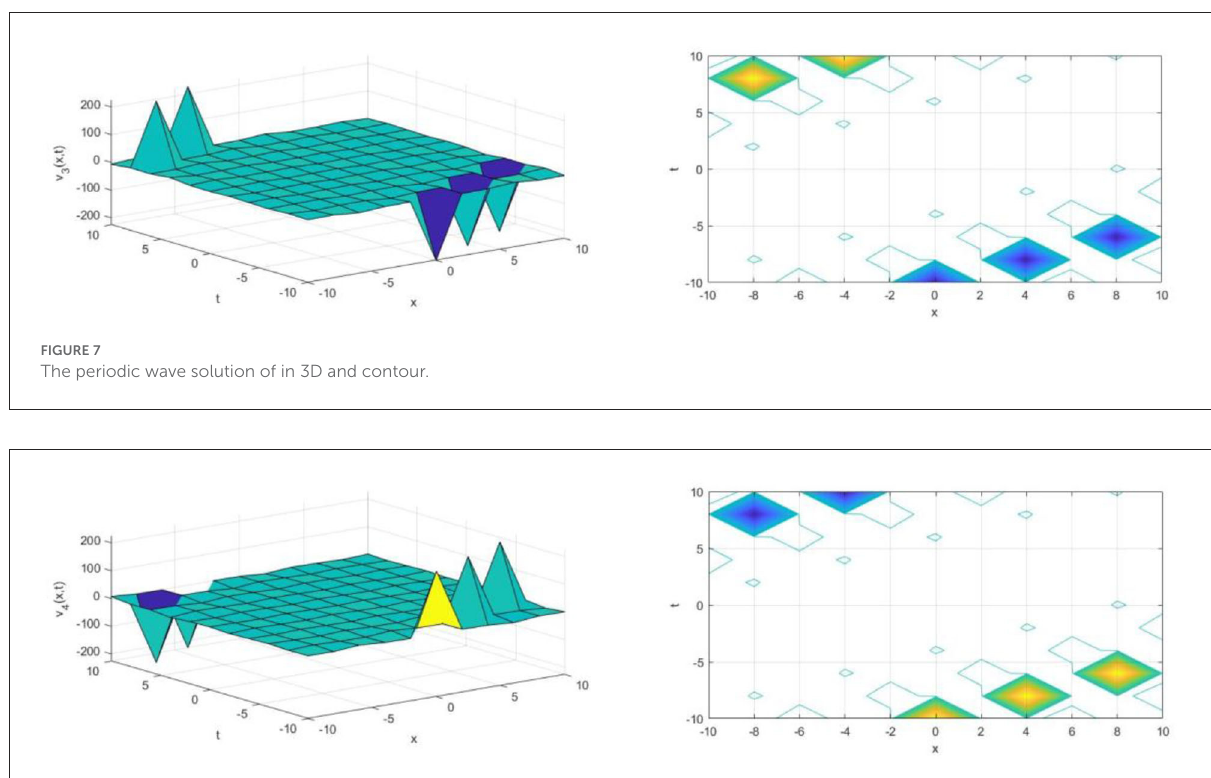
FIGURE8 The periodic wave solution of in 3D and